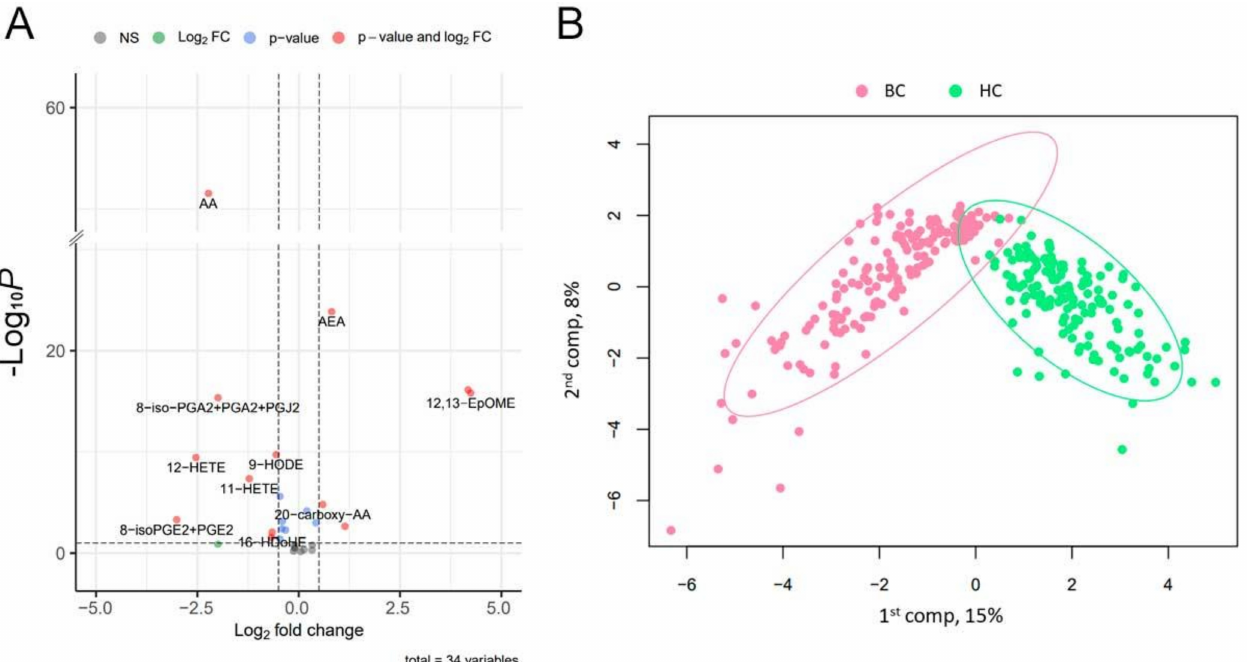
Figure 1. Concentration of oxylipin changes in BC patients. ( A ) Volcano plot indicating significantly changed compounds. X-axis indicates a log2 fold change of BC to HC patients. Y-axis indicates − log10 p -values (adjusted). The cut-off for p -values is indicated based on Bonferroni correction. Compounds that changed insignificantly are indicated in gray, compounds whose means changed in BC (relative to HC) more than twofold or less than twofold, but insignificantly, are indicated in green. Red dots stand for compounds that changed more than twofold and had a p -value (adjusted) < 0.05. ( B ) PLS-DA model discriminating against HC and BC. The explained variance of each component is indicated in brackets on the corresponding